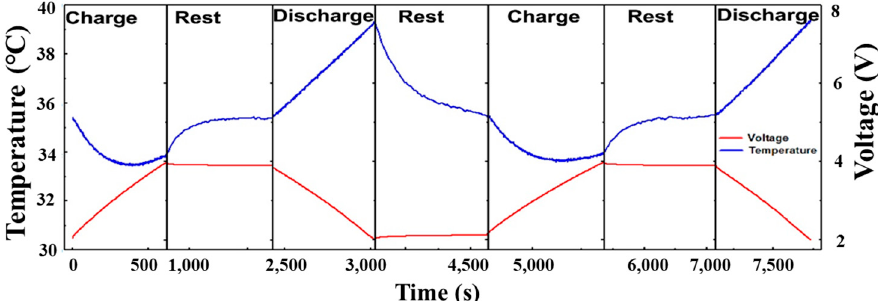
Figure 6. Temperature versus time during the charging and discharging process for an LIC with AC//SC (pre-lithiated soft carbon), reproduced with permission from [95]. Copyright 2019, Elsevier.